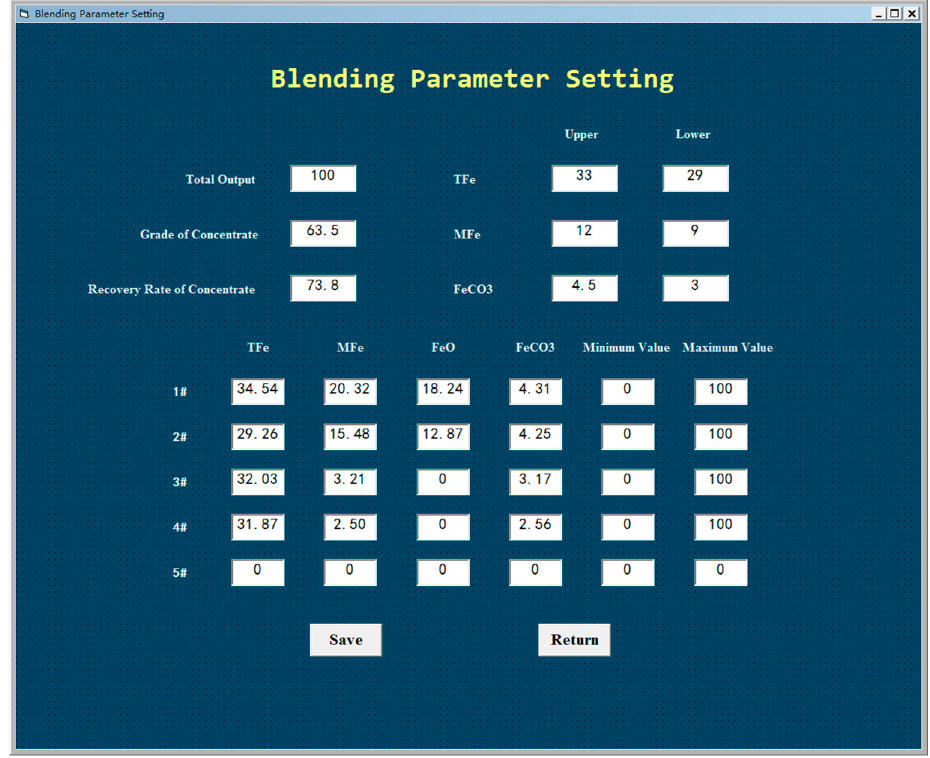
Figure 5. Interface for blending parameters setting. The model was solved by optimization algorithm and the ore selectivity index was calculated. Compared with the results obtained by the original method. This method took about 3 min to generate an optimized ore blending scheme on an ordinary computer.